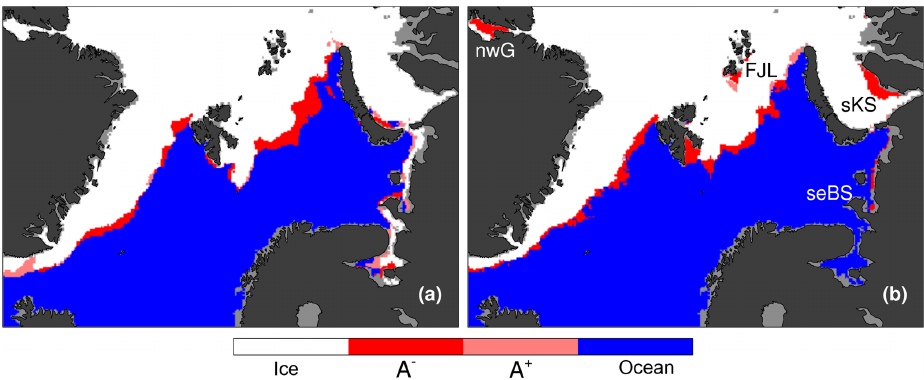
Figure 5. Map displaying the IIEE regions for two forecasts. Panels (a) and (b) display the results for the forecast for 3 April 2017 issued on 30 March 2017 and for the forecast for 29 May 2017 issued on 25 May 2017, respectively. Areas displayed in gray are not included in one or both products and are excluded in the present analysis. The following regions with ice edge discrepancies are labelled in panel (b) : near Franz Josef Land (FJL), southern Kara Sea (sKS), northwest of Greenland (nwG), and southeastern Barents Sea (seBS). The displayed region is nearly the same as the region with ice chart data (a slight zooming was applied in order to highlight features of interest, so narrow bands of grid cells from the ice chart data to the right and to the bottom are not shown). The colour codes for the various IIEE regions are the same as in Fig. 4. Table 3. Results for the various sea ice edge displacement metrics. Forecast 4–3 and Forecast 5–29 results are metrics for the forecast for 3 April 2017 issued on 30 March 2017 and for the forecast for 29 May 2017 issued on 25 May 2017, respectively. All 5d forecast results are averages for all weekly 2017 forecast bulletins with a 5d lead time. Bootstrap fraction is the difference between the 95 percentile and 5 percentile values from a bootstrap analysis of all 5d forecast results, divided by the corresponding average value. All values are in kilometres except the bootstrap fractions, which are non-dimensional. See the text for